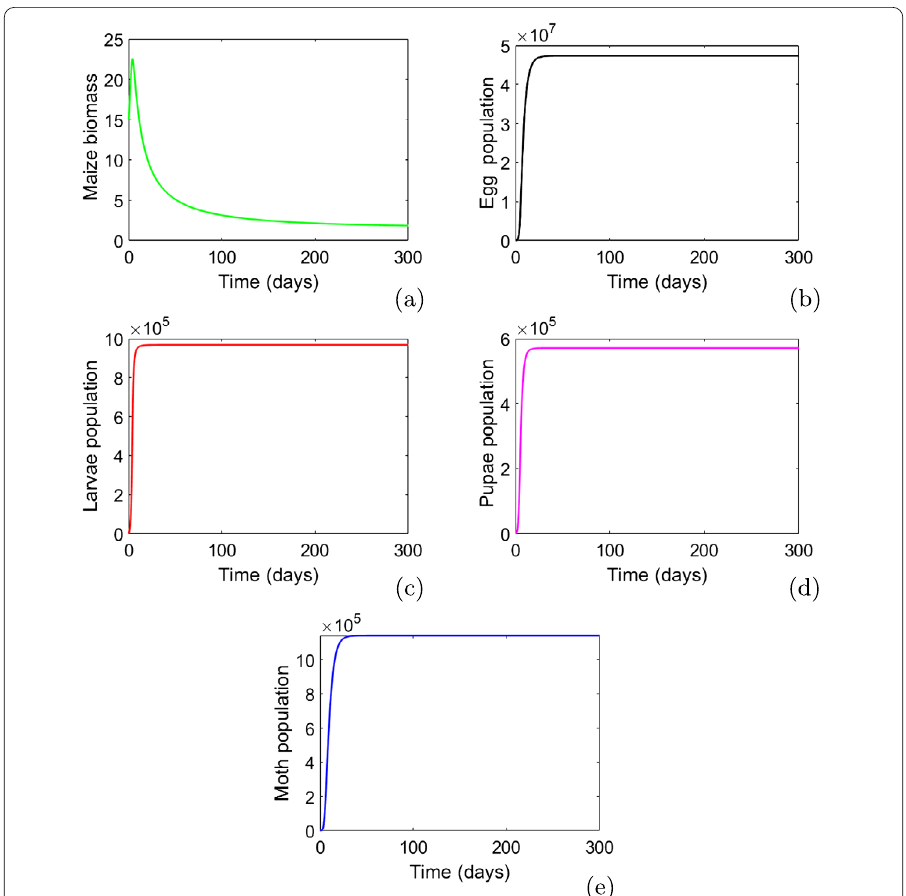
Figure 7 Model solutions showing the effects of a FAW outbreak with a large initial pest life cycle population, E (0) = 2000, L (0) = P (0) = 0, and A (0) = 15, coupled with less effective control measures, that is, u E = u L = 0.45 and u P = u A = 0, leading to R 0 = 58. We set q =